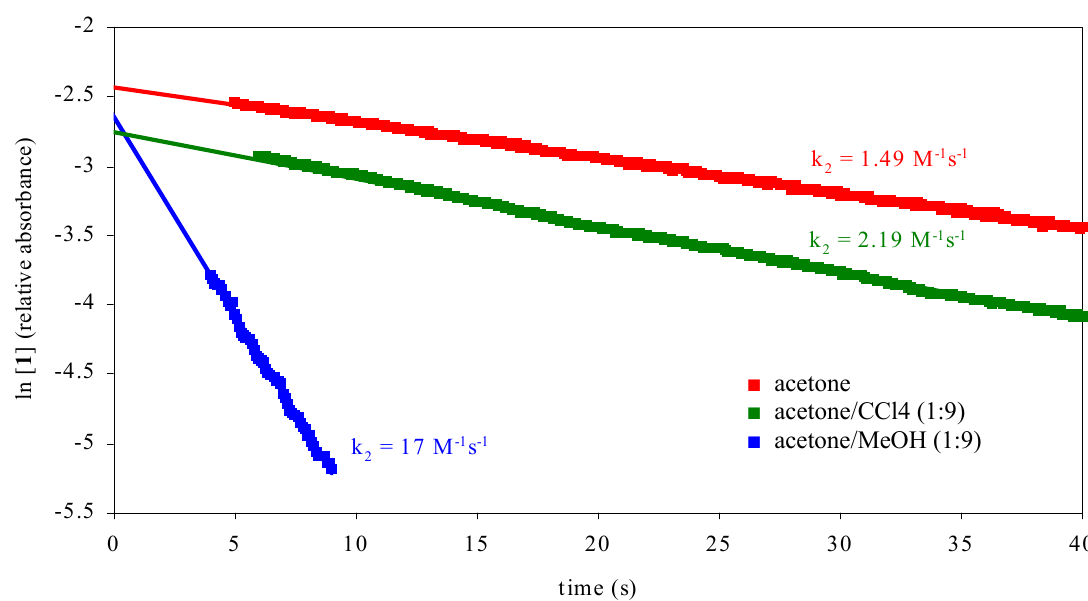
Figure 1. Representative Data for the Mono-Epoxidation of Geraniol by 1 in Various Dried Solvents at 23